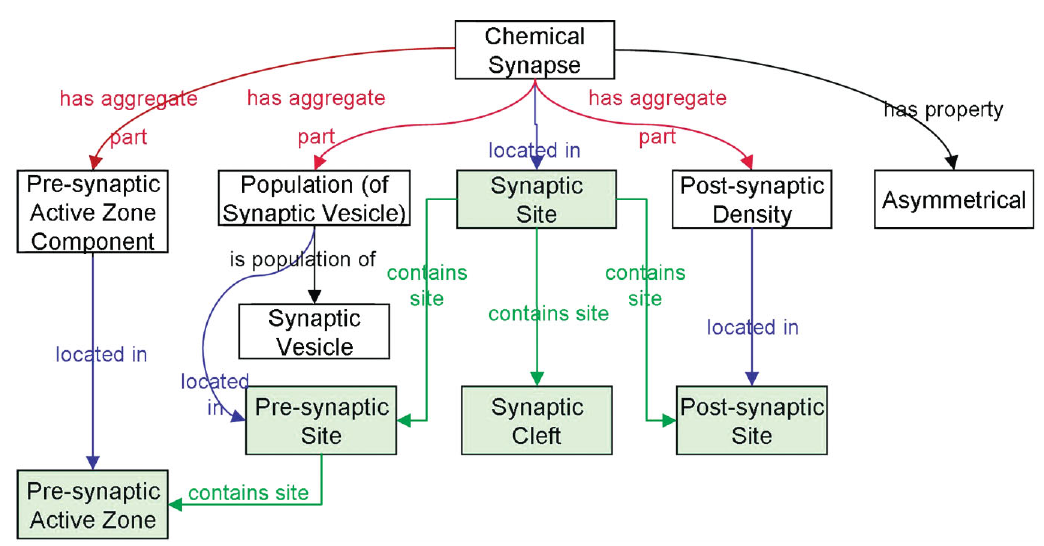
Figure 4. Diagram of a chemical synapse instance description in SAO . Sites are indicated by green backgrounds. The boxes indicate instances of classes that are related to one another as a description of a particular instance of a chemical